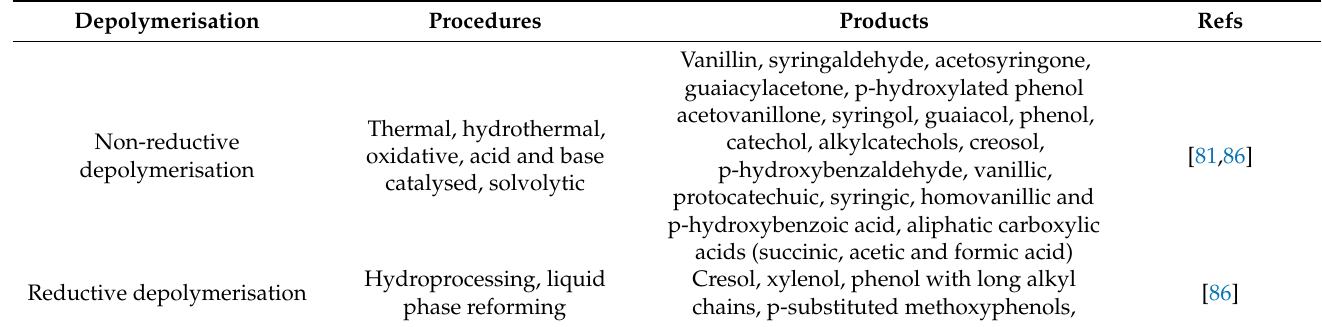
Table 8. Main procedures from lignin depolymerisation along with main products